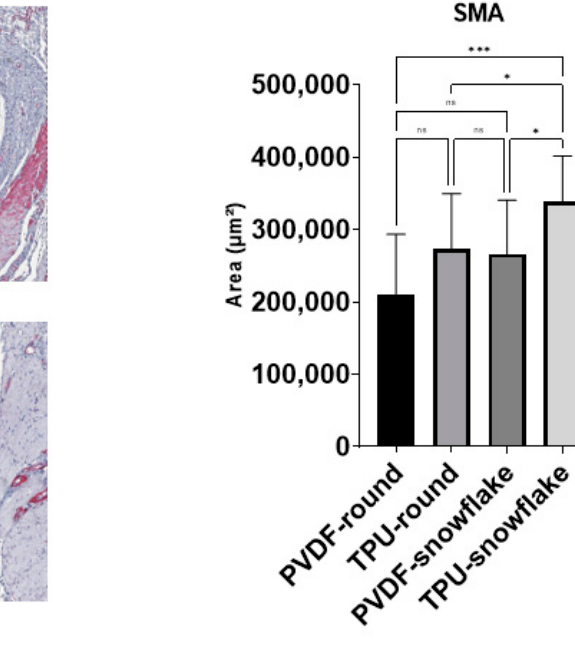
Figure 2 Immunohistological stainings for Ki67. ( a ) PVDF-round, ( b ) TPU-round, ( c ) PVDF-snowflake, ( d ) TPU-snowflake. There was a significant difference between the groups (F (3, 66) = 5.884, p = 0.0013). Abbreviations: ns: not significant, PVDF: polyvinylidene fluoride, TPU: thermoplastic polyurethane, ** indicates p < 0.01.